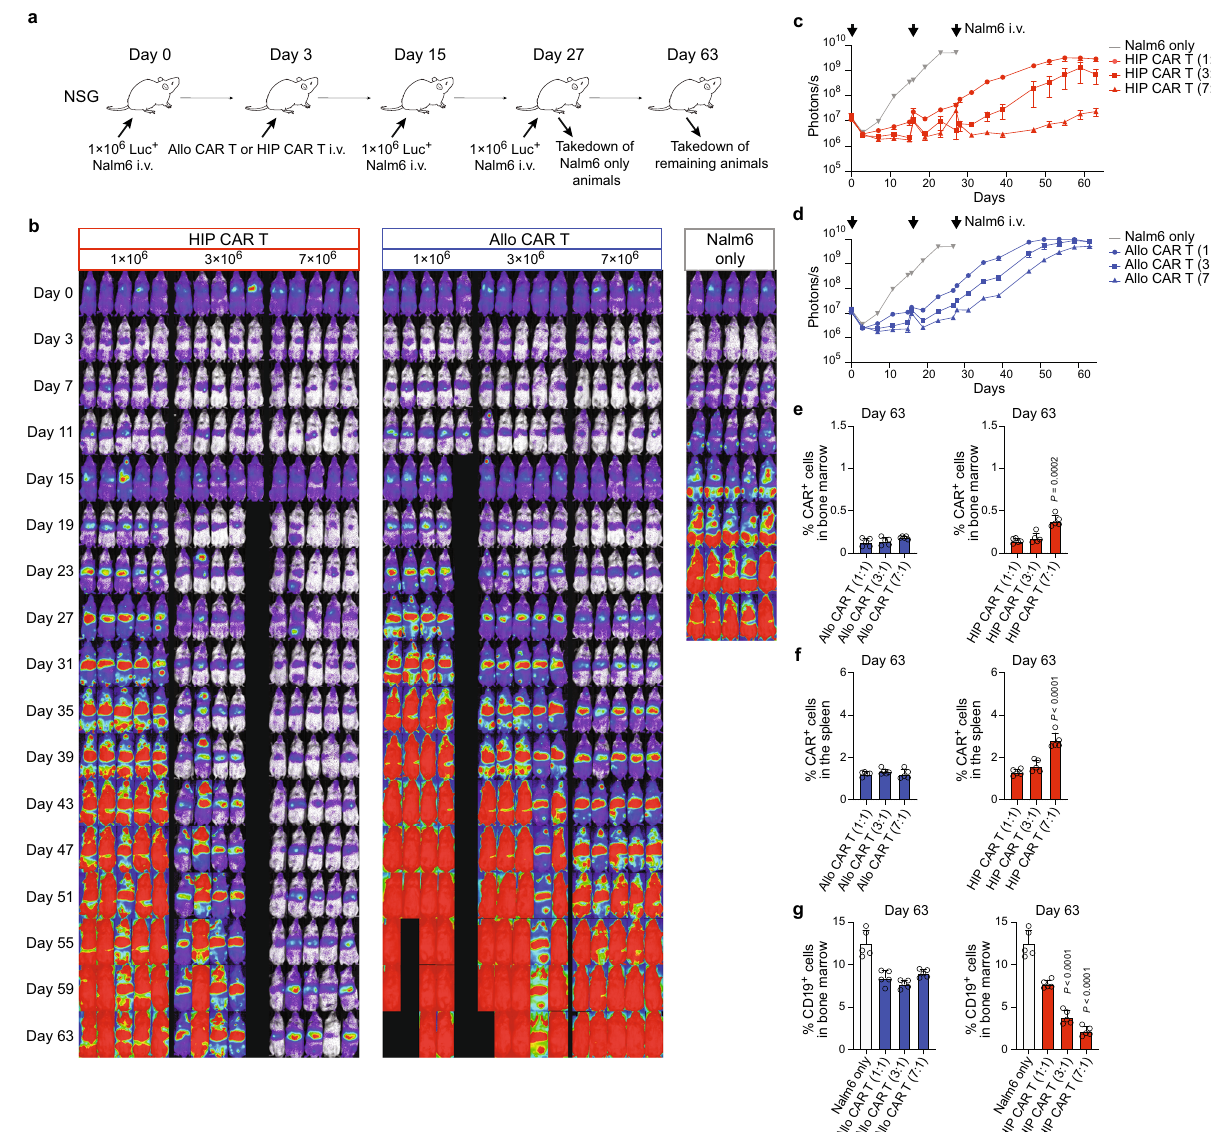
Fig.4|CARTcellsarerepeatedlyre-challengedwithNalm6tumorcellsinvivo. a Immunode fi cient NSG mice were injected with 1×10 6 Luc + Nalm6 cells and received different doses of allo CAR T cells or HIP CAR T cells on day 3. The mice were injected again on days 15 and 27 with Nalm6 cells. Spleen and bone marrow was taken after 27 or 63 days. b BLI images show the tumor burden for all mice in thisstudy. c , d GraphsshowBLIsignalsforanimalsintheHIPCART( c )andalloCAR T cell groups ( d , mean±SEM, n =5 animals per group in one experiment, arrows